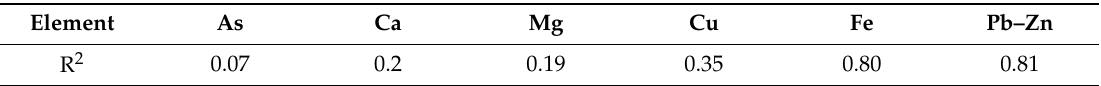
Table 2. Coe ffi cient of determination values for the prediction of each target element using the full-range FTIR reflectance spectra and partial least squares regression (PLSR).